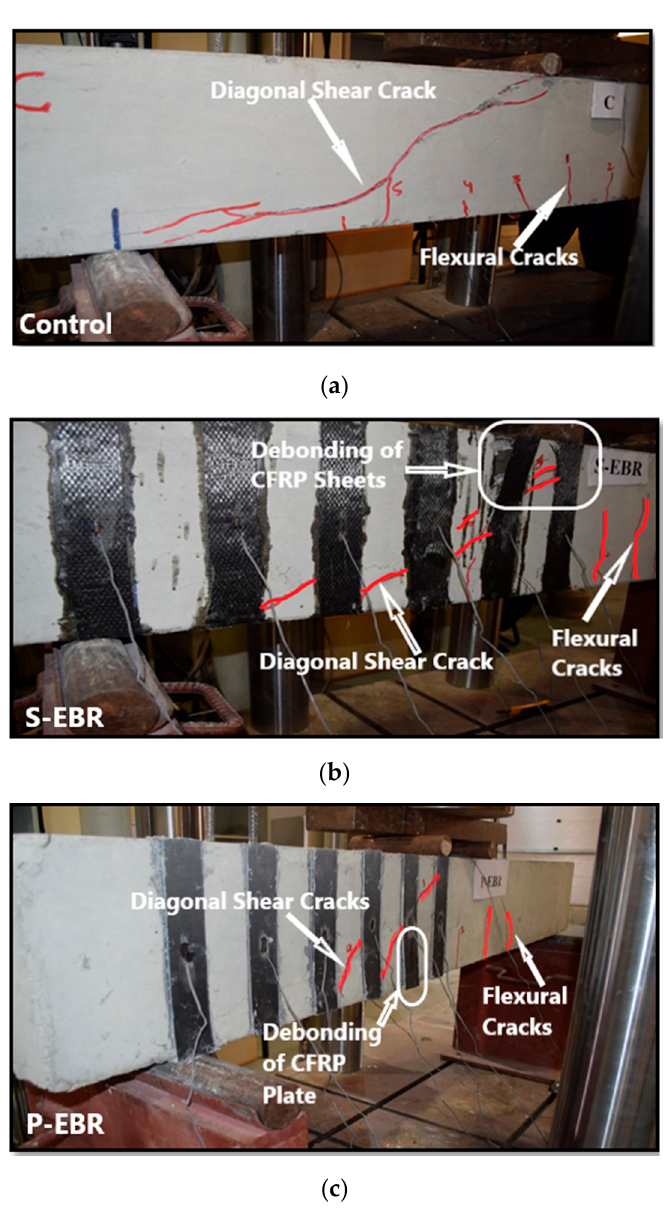
Figure 7. Failure modes: ( a ) Diagonal shear crack on the control beam; ( b ) debonding of CFRP sheets in S-EBR; ( c ) debonding of CFRP plates in